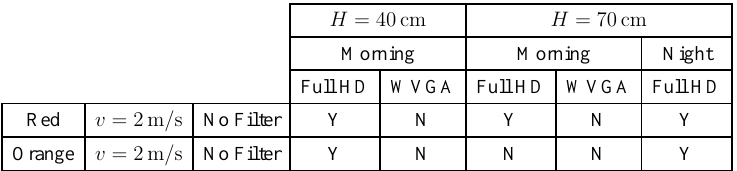
Table 2. Summary of the red- and orange-fluorescent particle